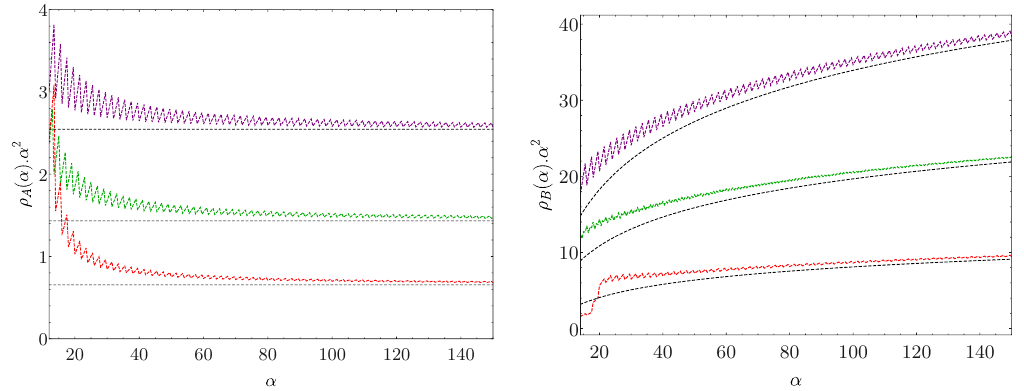
Figure 12. Left: the spectral density ρ A ( α ) multiplied by α 2 , for ∆ = 2 (purple), ∆ = 2 . 5 (green) and ∆ = 4 (red), averaged over intervals [ α − 2 , α + 2] (since the densities have delta function support). The horizontal dashed lines are the large- α predictions from formula (4.40). Right: the same plot for the spectral density ρ ( α ) , plus comparison to the asymptotic formula (4.40) B